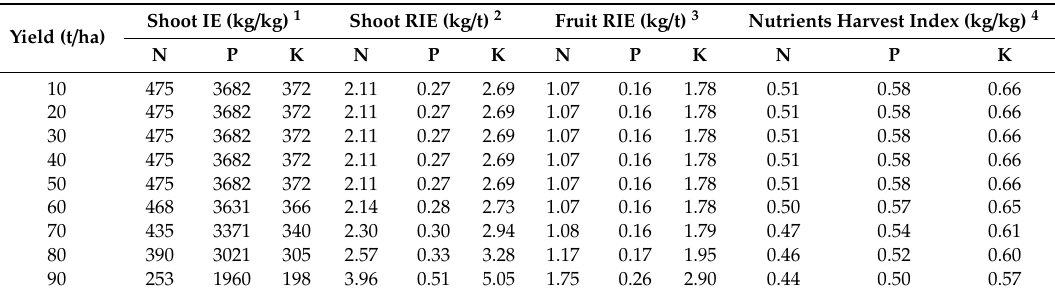
Table 7. Internal e ffi ciency (IE), the reciprocal internal e ffi ciency (RIE) of N, P, and K in the shoot and fruit, and removal ratio at di ff erent target yields simulated by the QUEFTS model for watermelon in China with a potential yield of 90 t /